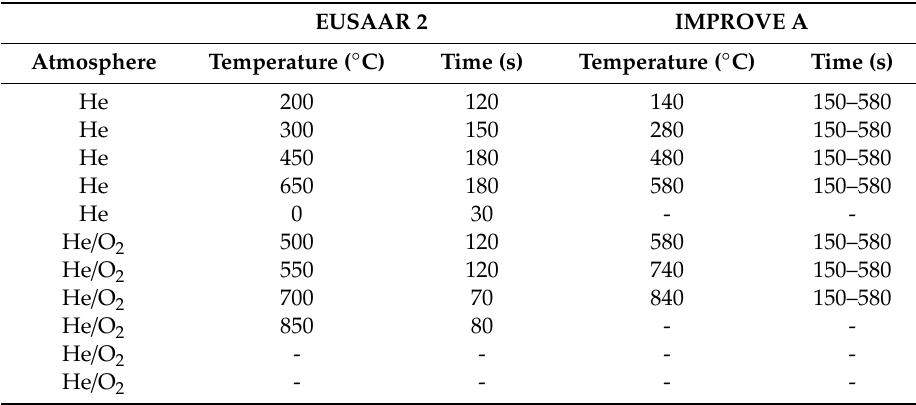
Table 1. Various protocols used in thermal optical OCEC analysis and their parameters, EUSAAR 2 (EUropean Supersites for Atmospheric Aerosol Research) and IMPROVE (Interagency Monitoring of Protected Visual